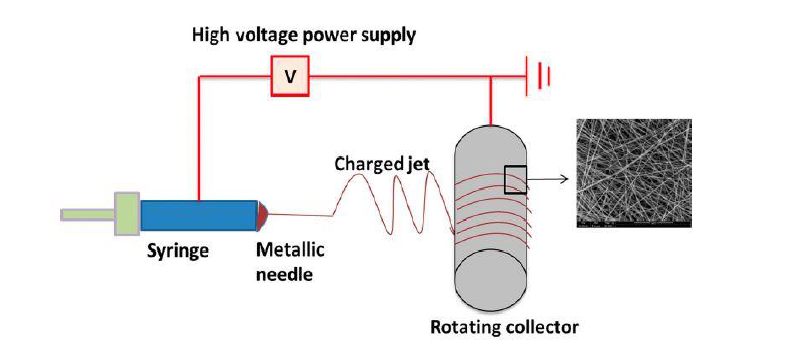
Figure 1: Electrospinning system with a rotating